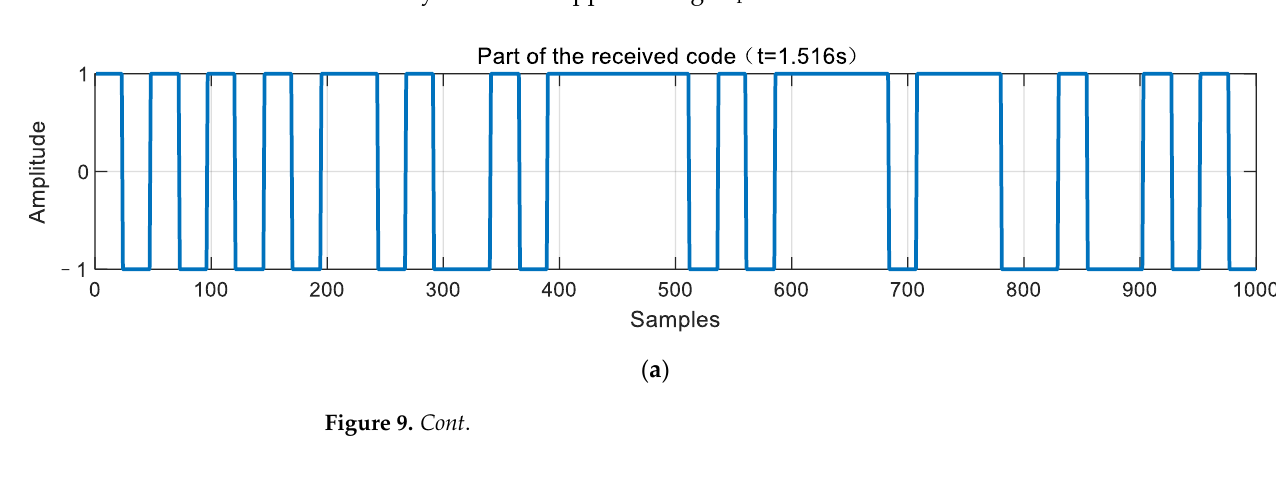
( b ) ( c ) Figure 9. Transition process of the received PRN code. ( a ) Initial form of received PRN code; ( b ) Intermediate form of the received PRN code; ( c ) Final form of the received PRN code. Figure 10 shows a diagram of the deception process of the proposed traction strate- gy. In the dark-blue area, there is a procedure for generating the spoofing traction code, which is also a key step that differs from the other traction processes.